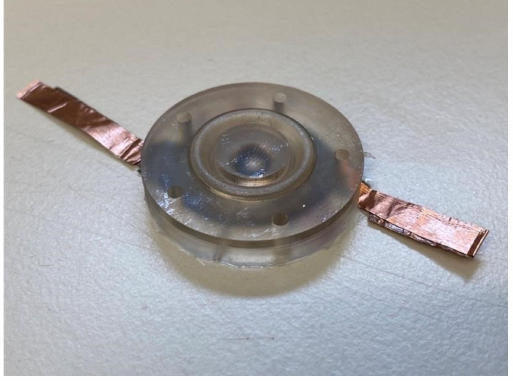
Figure 17. Picture of the optimized DEA